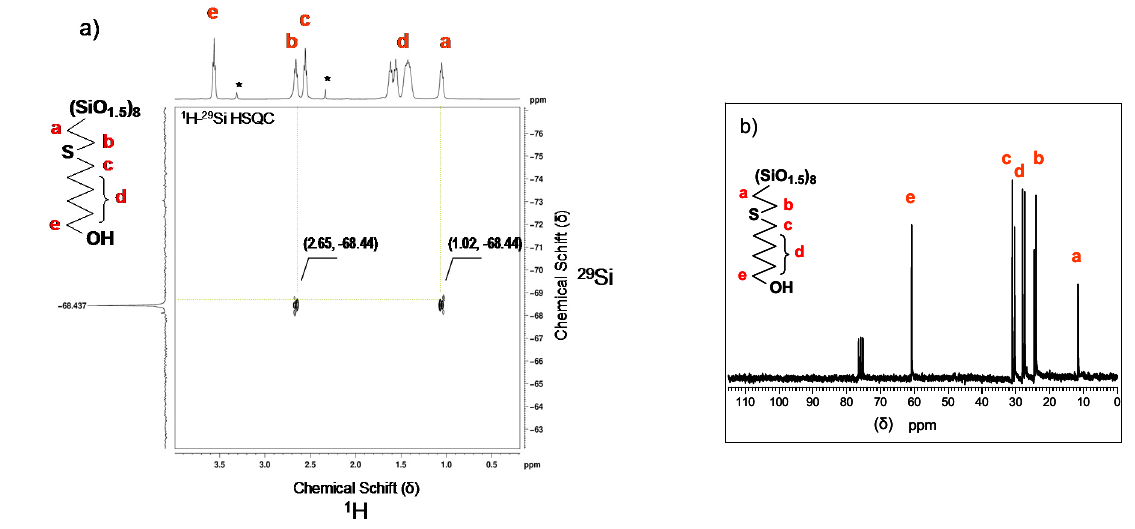
Figure 1. NMR spectra of octakis-2[(6-hydroxyhexyl)thio]ethyl-octasilsesquioxane, (POSS-S-OH)(1) ( a ) 1 H– 29 Si HSQC in CD 3 OD, (*-solvents); ( b ) 13 C NMR in CDCl 3